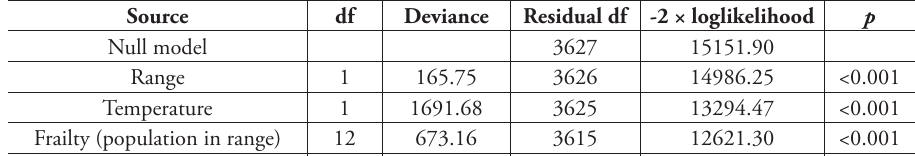
table 1. Analysis of deviance results for the AFT model. The results show the differences in the time to ger-